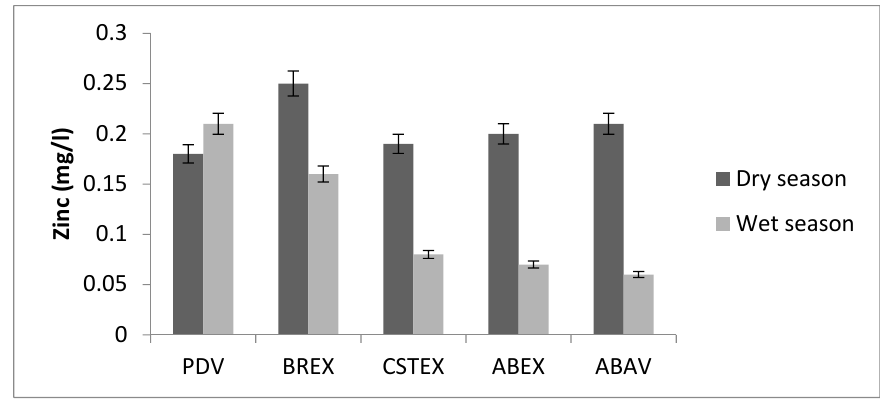
Figure 3. Zinc concentration.